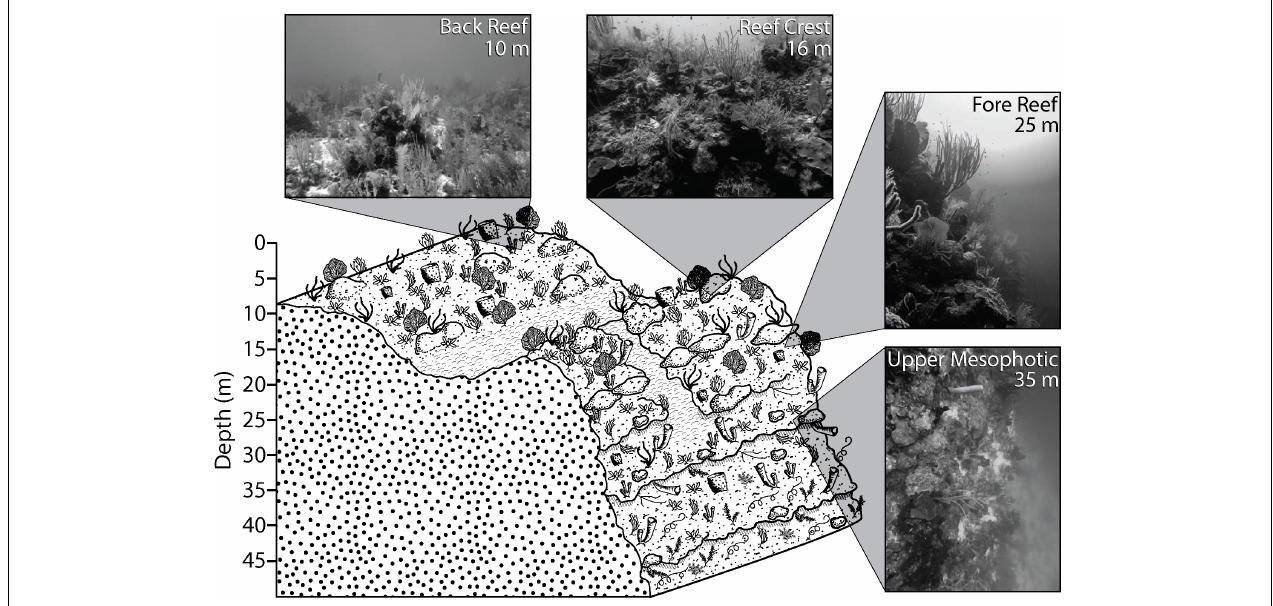
FIGURE 1 | Generalized reef structure and sampling depths on the Belize Barrier Reef. Inset photographs are representative of typical habitat at sampling depths. Figure from Eckert et al.